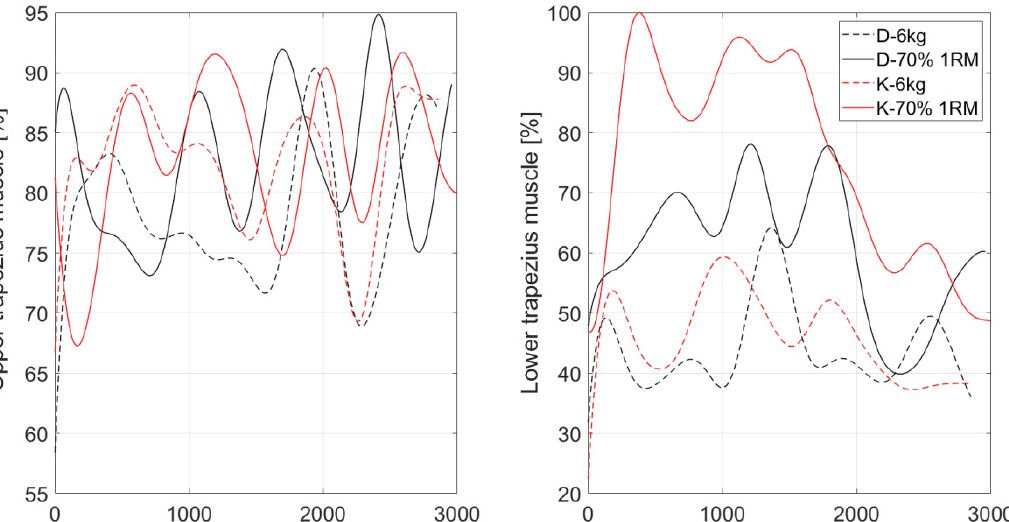
Figure 4. Example waveform of normalized muscle activity for upper and lower trapezius muscles, where: D-6kg—6 kg dumbbell press, K-6kg—6 kg kettlebell press, D-70% 1RM—70% of the 1RM dumbbell press, K-70% 1RM—70% of the 1RM kettlebell press. Table 4. Median, lower and upper quartile [Q1; Q3] of the maximum activity of the serratus anterior and spinal erector- thoracis part, where: D-6kg—6 kg dumbbell press, K-6kg—6 kg kettlebell